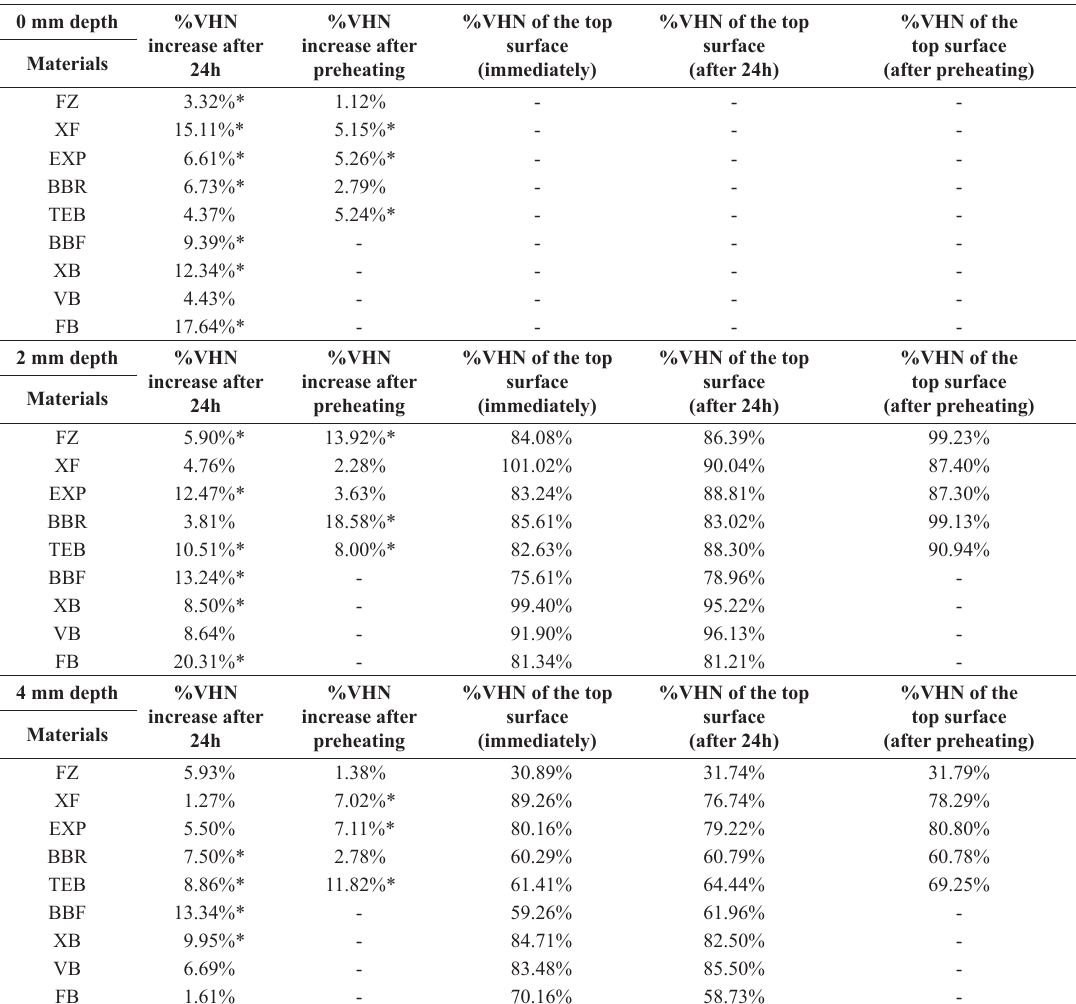
Table 2. The increase of microhardness (%VHN) of each tested RBC material after 24 h and after preheating. The symbol * indicate statistically significant increase in microhardness (p<0.05) . Moreover, the reduction of microhardness as the depth increases is also presented for each material and is expressed in %VHN of the top surface (0 mm depth). Microhardness requirement: ≥80%VHN of the top